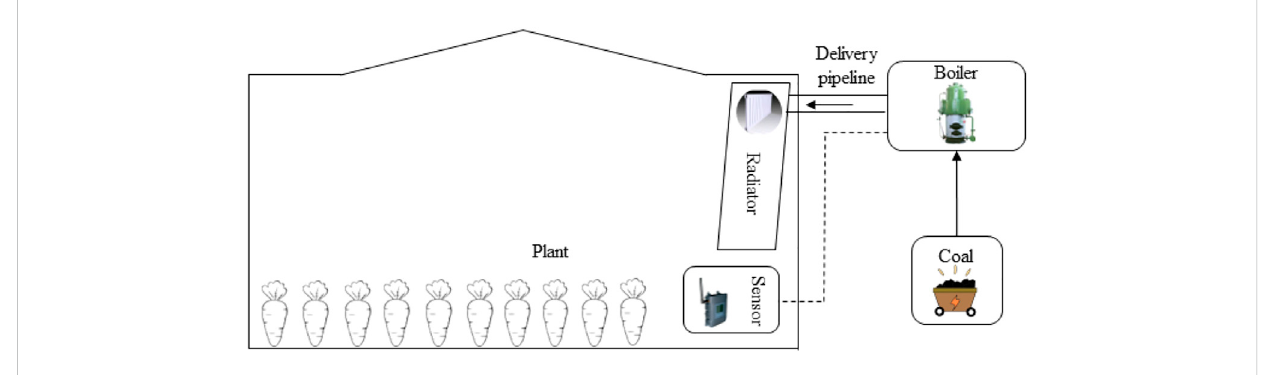
FIGURE 4 Boiler-type greenhouse energy